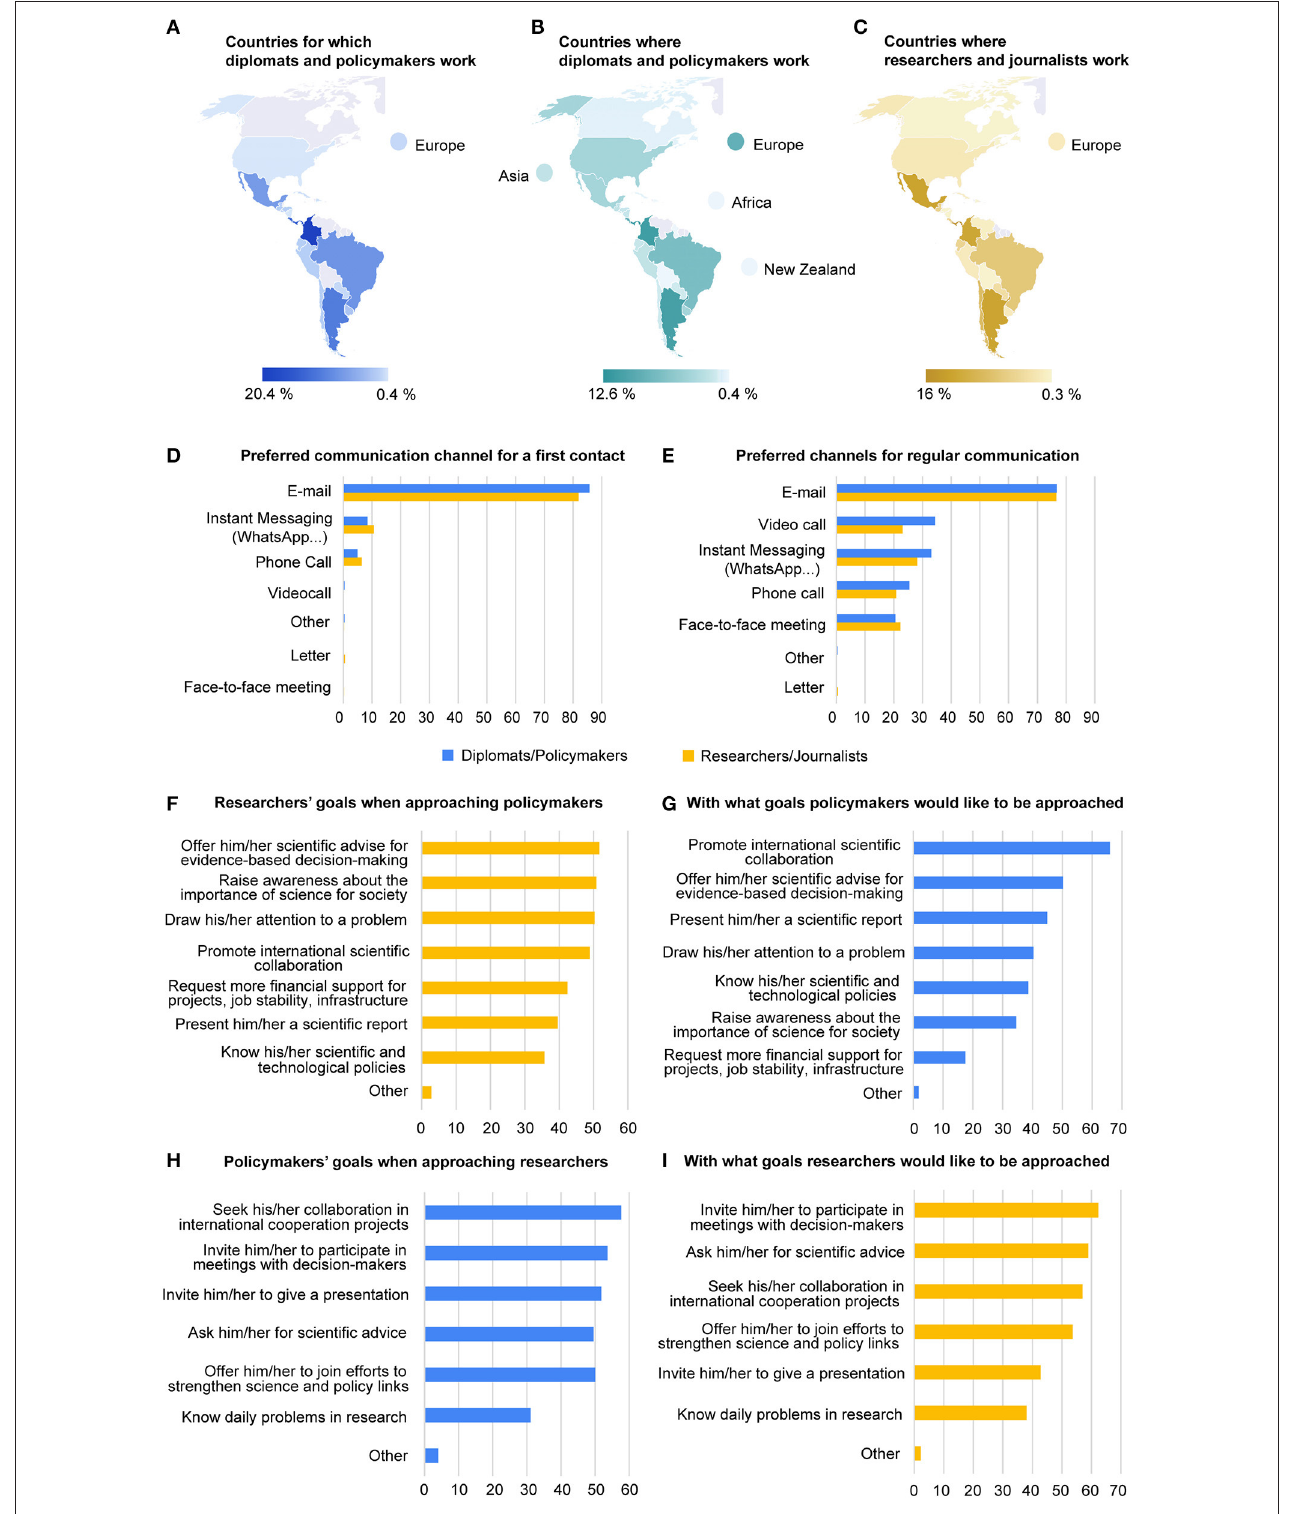
FIGURE 1 | (A) Countries for which diplomats and policymakers work. (B) Countries where diplomats and policymakers carried out their professional activity. (C) Countries where researchers and journalists carried out their professional activity. (D) Preferred communication channels to stabilize a first contact according